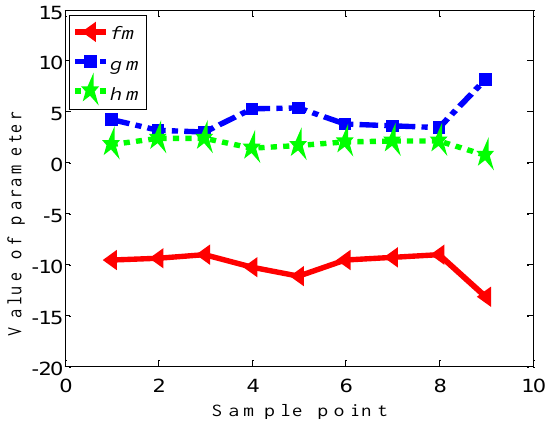
Figure 6. Values of parameter fm , gm , and hm .